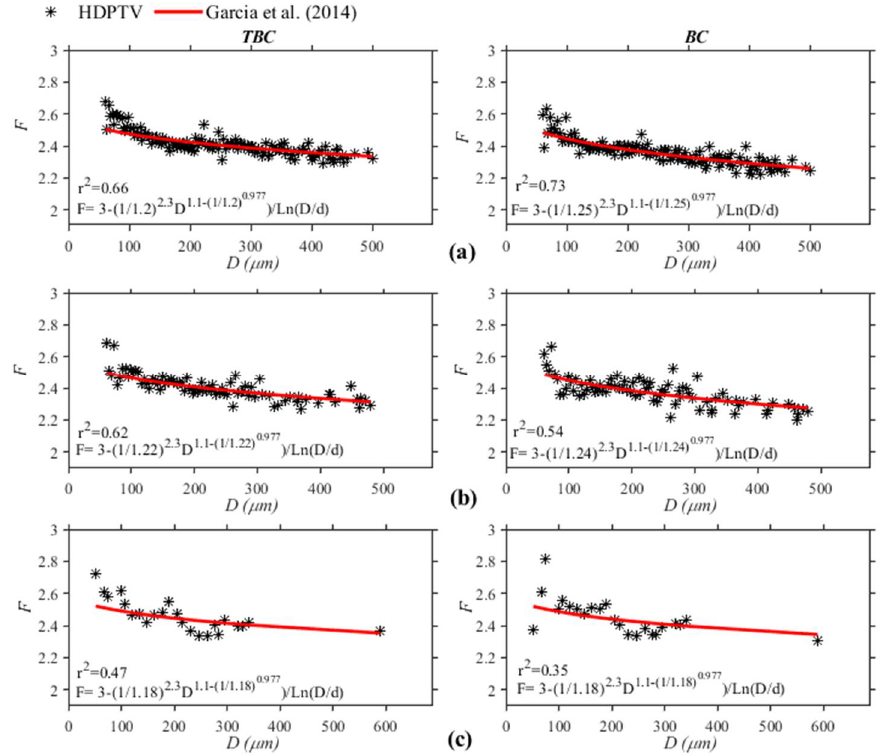
Figure 9. Best fit of the fractal dimension for the Usumacinta River with Garcia Aragon et al. [16] model at different flocculation times using TBC and BC methods; ( a ) 30 minutes, ( b )45 minutes, ( c ) 60 minutes.